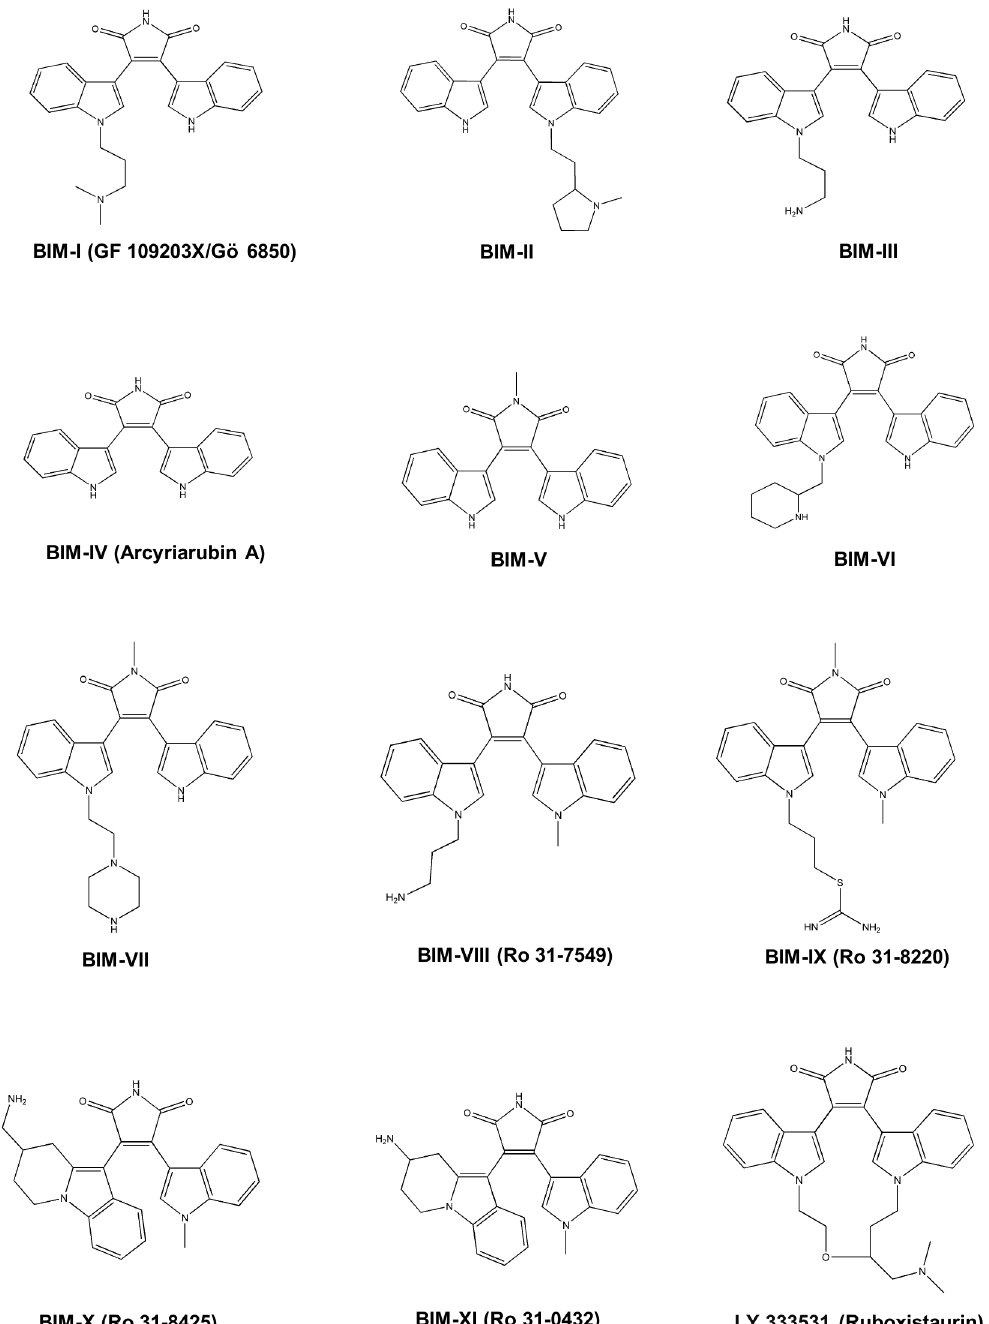
Fig 1. Chemical structures of